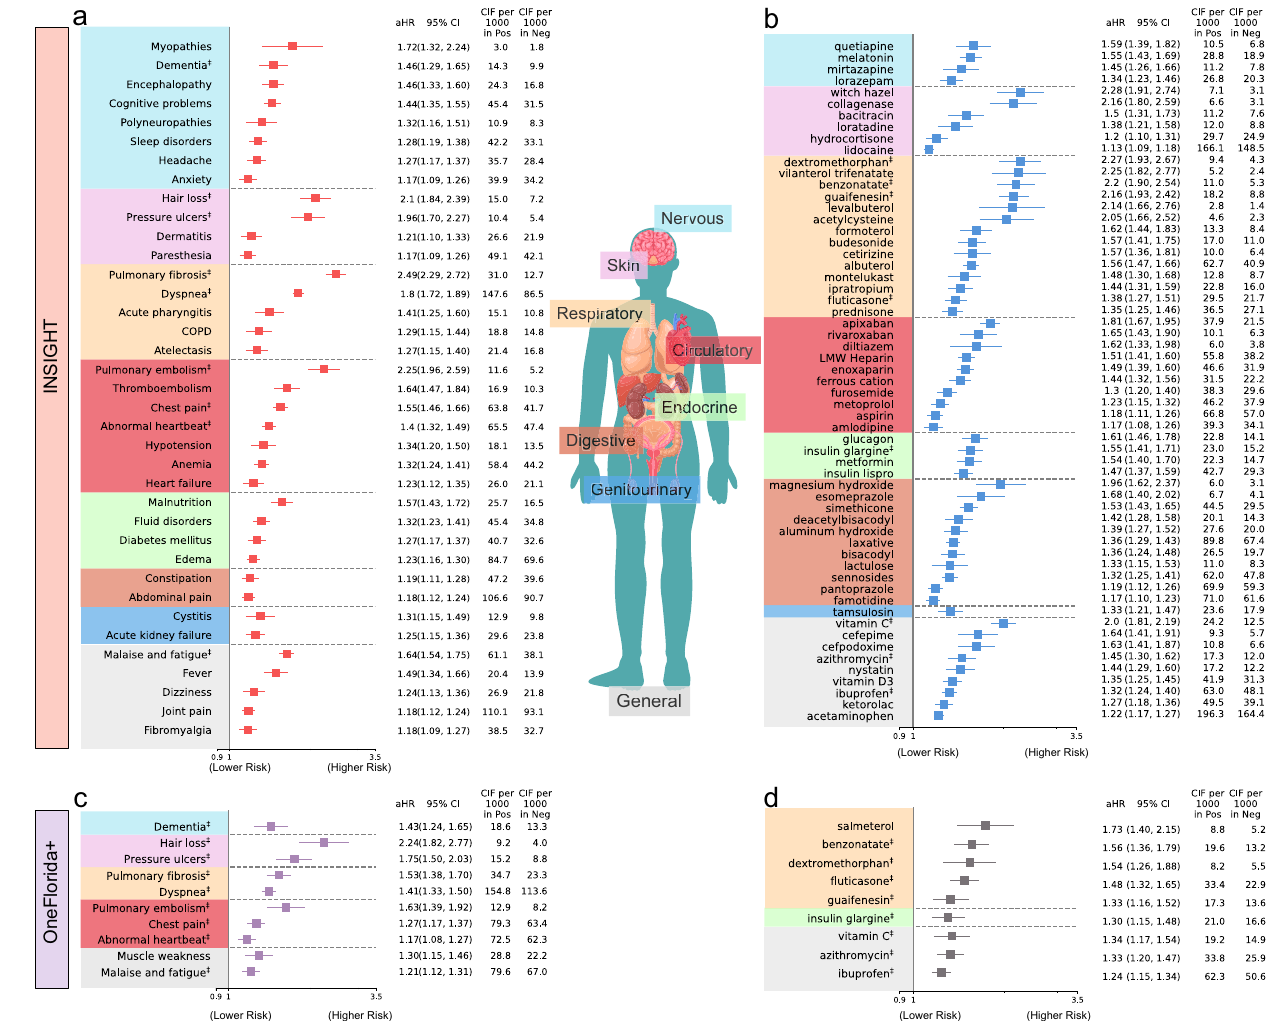
Fig. 2 | Identi fi ed potential incident PASC conditionsfromtheINSIGHTcohort and the OneFlorida+ cohort, March 2020 to November 2021. a The risk of incident diagnoses from INSIGHT. b The risk of incident medications from INSIGHT. c The risk of incident diagnoses from OneFlorida+. d The risk of incident medications from OneFlorida+. The incident risk was quanti fi ed by the adjusted hazard ratios with 95% con fi dence intervals, and we also reported the adjusted cumulative incidences per 1000 patients in both the SARS-CoV-2 positive and the negative groups. The sequelae outcomes were ascertained from day 30 after the SARS-CoV-2infectionandcomputed180daysaftertheSARS-CoV-2infection.PASC conditions were selected based on adjusted hazard ratio > 1, the aHR ’ s P